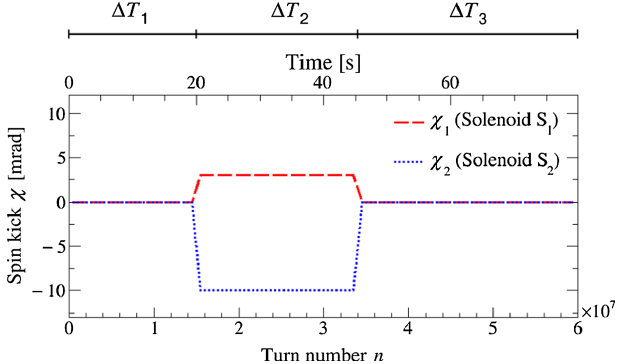
FIG. 2. Timing of spin kicks χ 1 (see Eq. [(34)]) of the two ; 2 solenoids S 1 and S 2 during a measurement cycle. The achievable field integrals and spin kicks are listed in Table